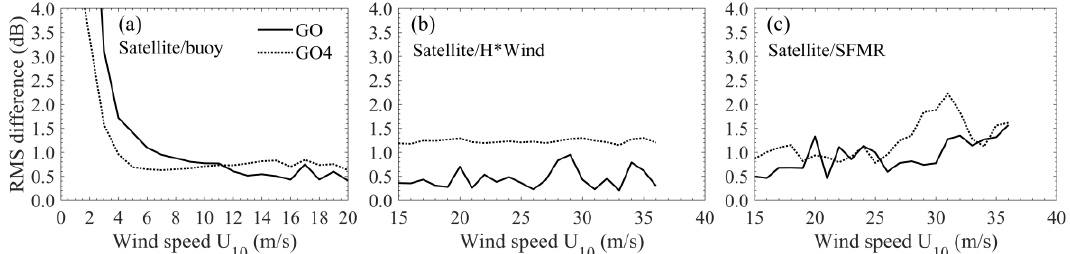
Figure 9. RMS differences between the NRCSs computed with the fitted GO (solid lines) and GO4 (dotted lines) models and the bin-averaged NRCS measurements from ( a ) the satellite/buoy data, ( b ) the satellite/H*Wind data, and ( c ) the satellite/SFMR data at all incidence angles as functions of wind speed.